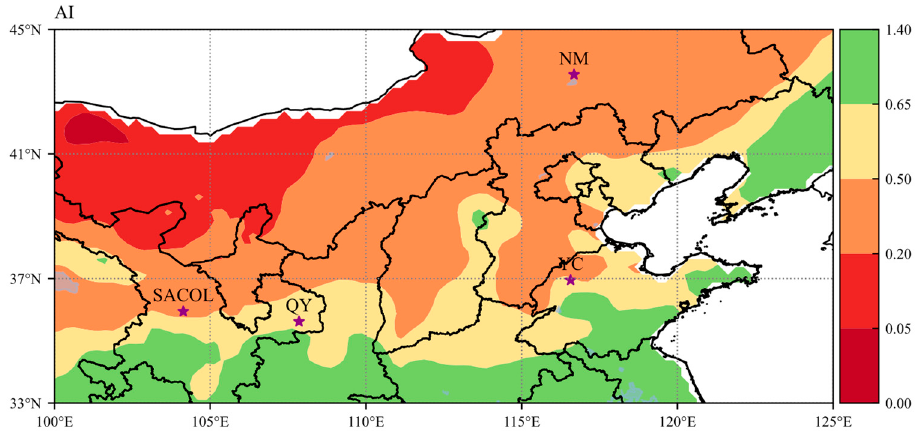
Figure 1. Climatic background of climate transitional zone of northern China (hyper-arid: AI < 0.05,